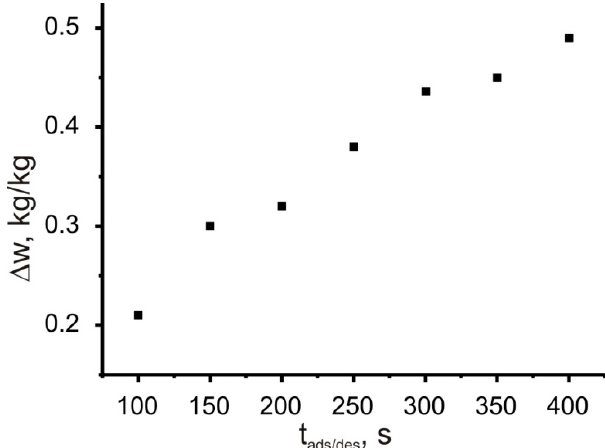
Figure 9. The amount of methanol exchanged in a cycle for different durations of the adsorption– desorption stage.